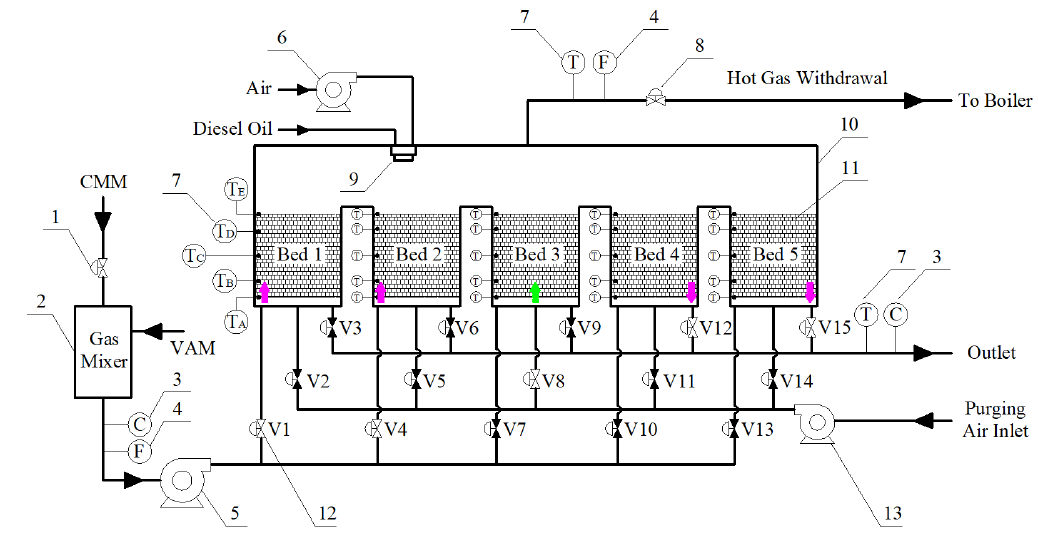
Figure 1. Diagram of the industrial-scale VAM oxidation system 1: flow control valve, 2: gas mixer, 3: methane concentration sensor, 4: flow sensor, 5: fan, 6: combustion fan, 7: thermocouples, 8: flow control valve for high-temperature gas, 9: diesel burner, 10: multibed TFRR, 11: honeycomb ceramics, 12: switching valves (V1-V15), 13: purging fan.